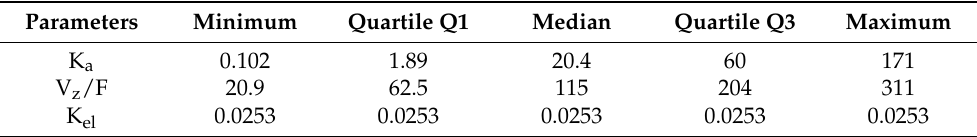
Table 1. Estimated population model parameters for serum doxycycline concentration after intragas- tric administration of doxycycline at 10 mg/kg q12 h from 0 to 48 h in 8 healthy jennies. Parameters Unit Point Estimate Relative Standard Error % K a pop. h − 1 10.3 45.3 V z /F pop. L/kg 108 24.4 K el pop. h − 1 0.0253 9.82